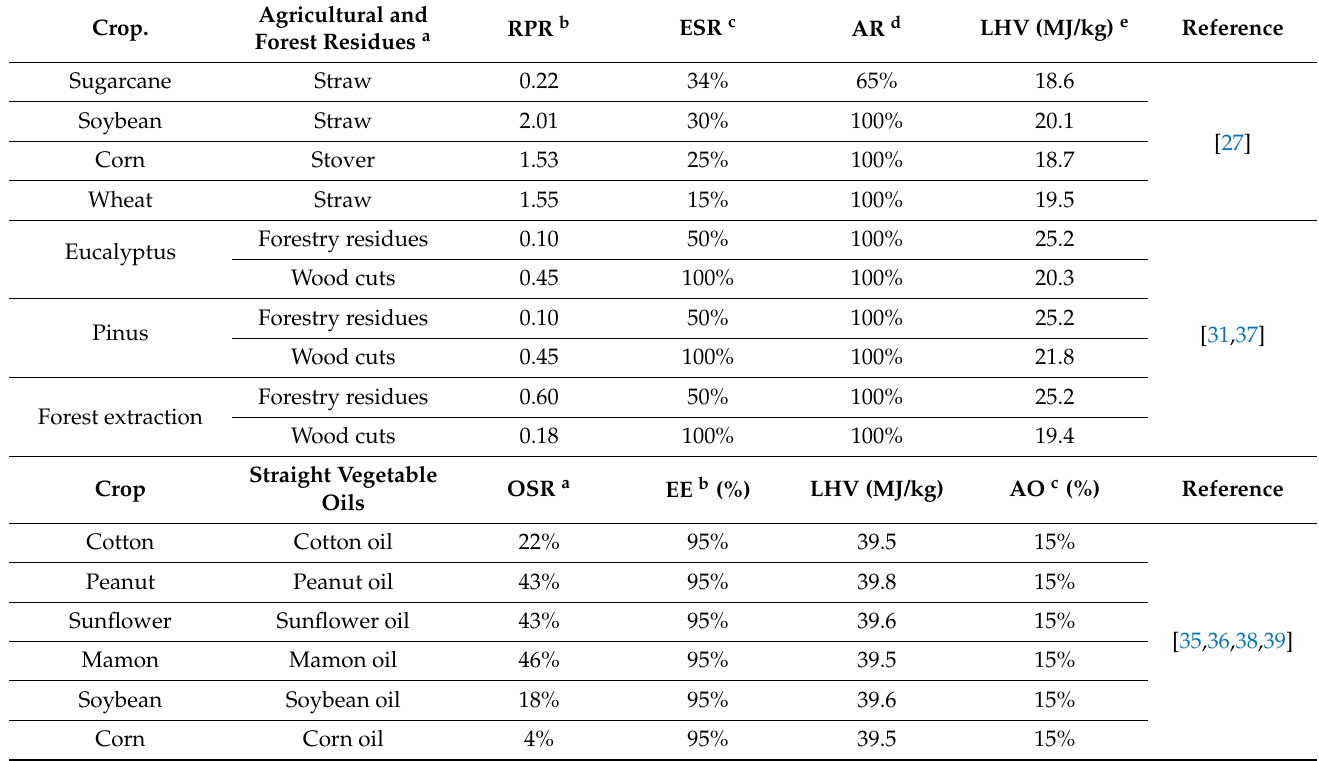
Table 1. Parameters considered for potential estimates in Brazil. Notes for agricultural residues: a : Wood cuts represent primary forest residues, i.e., obtained until the basic product production (charcoal, wood chips, and sawdust), including cutting and peeling activities. Forestry residues are timber and other forest products that remain with no defined use due to technological or market limitations [31]; b : For agricultural residues an average factor was considered based on [27]. For forest residues, data from [31,32] were considered; c : Based in [27,31,32]; d : Regarding sugarcane, a coefficient that expresses residues availability for energy purposes was adopted. In this study, it was assumed that 65% of sugarcane straw is available for energy production, taking into consideration the rate of agricultural fields that use mechanical harvesting without open-air burning [27,32–34]; e : Dry basis. Notes for straight vegetable oils: a : Obtained from average values from Brazilian institutions [35,36]; b : The same efficiency in oil extraction was considered for all crops; c : Oil availability factors were based on OECD/FAO projections for vegetable oils utilization in food industry (49%) and biofuels production (36%) in the period from 2021 to 2018. Thus, vegetable oil availability to produce maritime biofuels discounts its utilization in its current markets. Same availability factor was considered for all oils, although not all are used for biofuels production. Agricultural and Crop. RPR b ESR c AR d LHV (MJ/kg) e Reference Forest Residues a